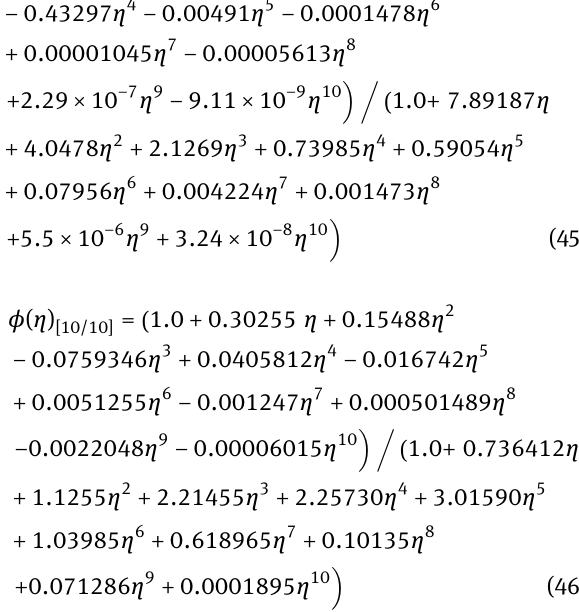
Fig. 2: Comparison of velocity profile with RK4 and 20 th order DTM- Padè